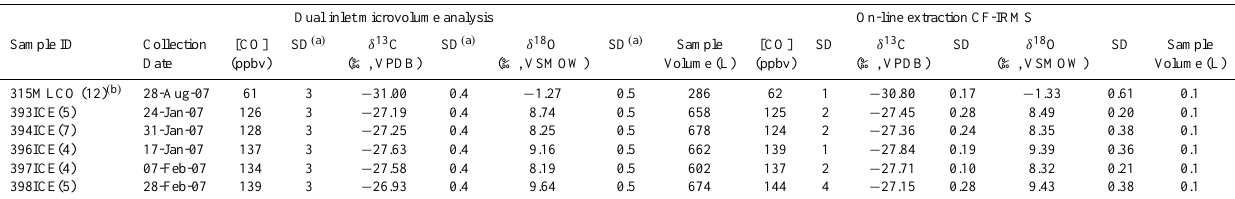
Table 4. Comparison of δ 13 C and δ 18 O results of field CO samples obtained by dual inlet microvolume analysis and online extraction CF-IRMS.